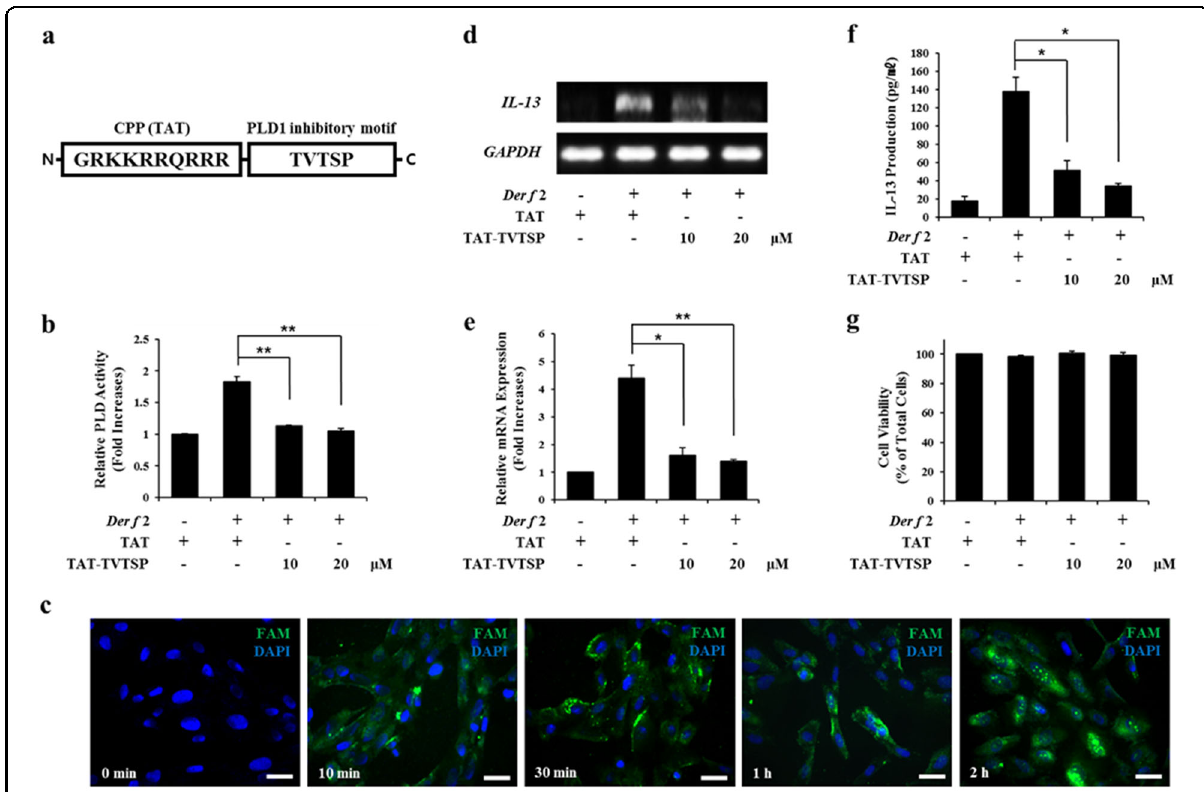
Fig. 1 TAT-TVTSP effectively reduces Der f 2-induced PLD activation and IL-13 production in BEAS-2B cells. a PLD1-speci fi c inhibitory peptide (TVTSP) was fused with the cell-penetrating peptide delivery system (TAT). b BEAS-2B cells were labeled with 2 µCi/ml [ 3 H]-palmitic acid and then pretreated with TAT or TAT-TVTSP at the indicated concentrations for 2 h, followed by stimulation with 20 µg/ml Der f 2 for 30 min. PLD activities were determined by estimating [ 3 H]-PBt in the presence of 1-butanol. The results are expressed as the means ± SD of three independent experiments. ** P < 0.01 compared with TAT-TVTSP (10 µM) + Der f 2/TAT + Der f 2 or TAT-TVTSP (20 µM) + Der f 2/TAT + Der f 2. c BEAS-2B cells were treated with TAT-TVTSP-FAM and examined over time. FAM fl uorescent signals were examined with a fl uorescence microscope. Scale bar, 20 µm. d , e Total RNA was isolated using Trizol reagent, and the mRNA levels of IL-13 and GAPDH were determined by RT-PCR ( d ) and real-time RT-PCR ( e ). The results are expressed as the means ± SD of three independent experiments. * P < 0.05 compared with TAT-TVTSP (10 µM) + Der f 2/TAT + Der f